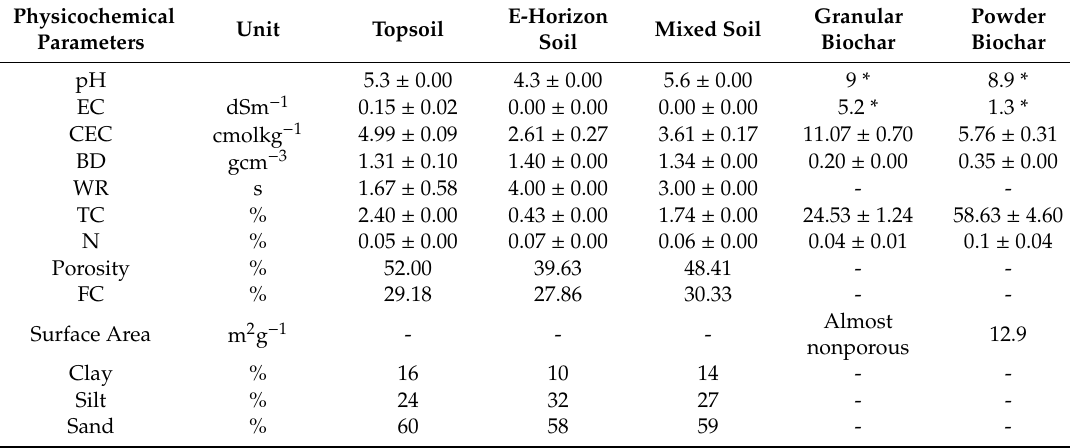
Table 1. Physicochemical properties of soil and